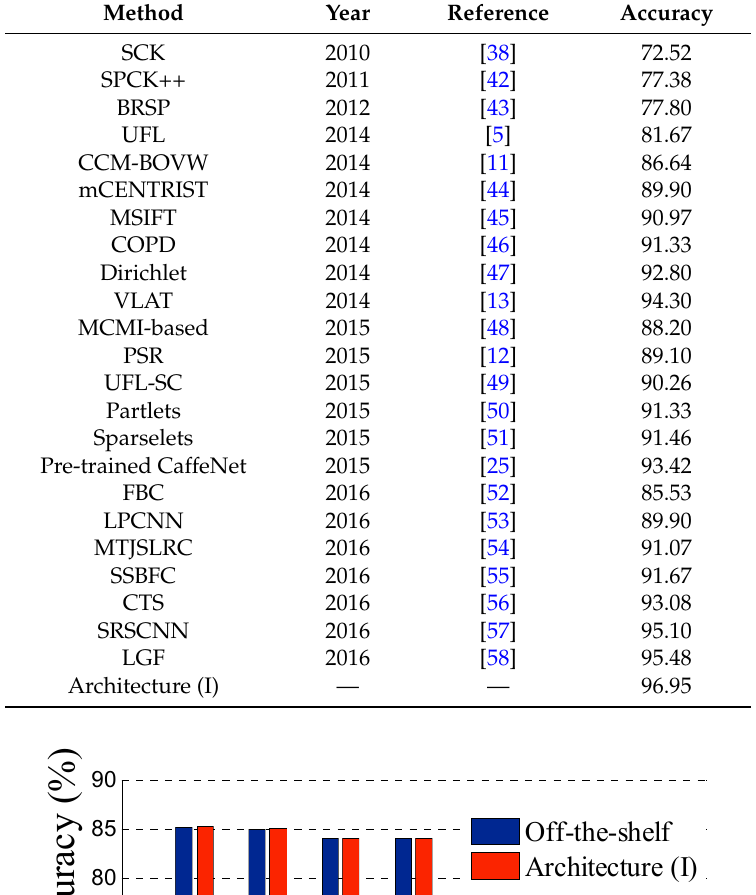
Table 4. Classification accuracy (%) of reference and proposed methods on the UC Merced dataset.